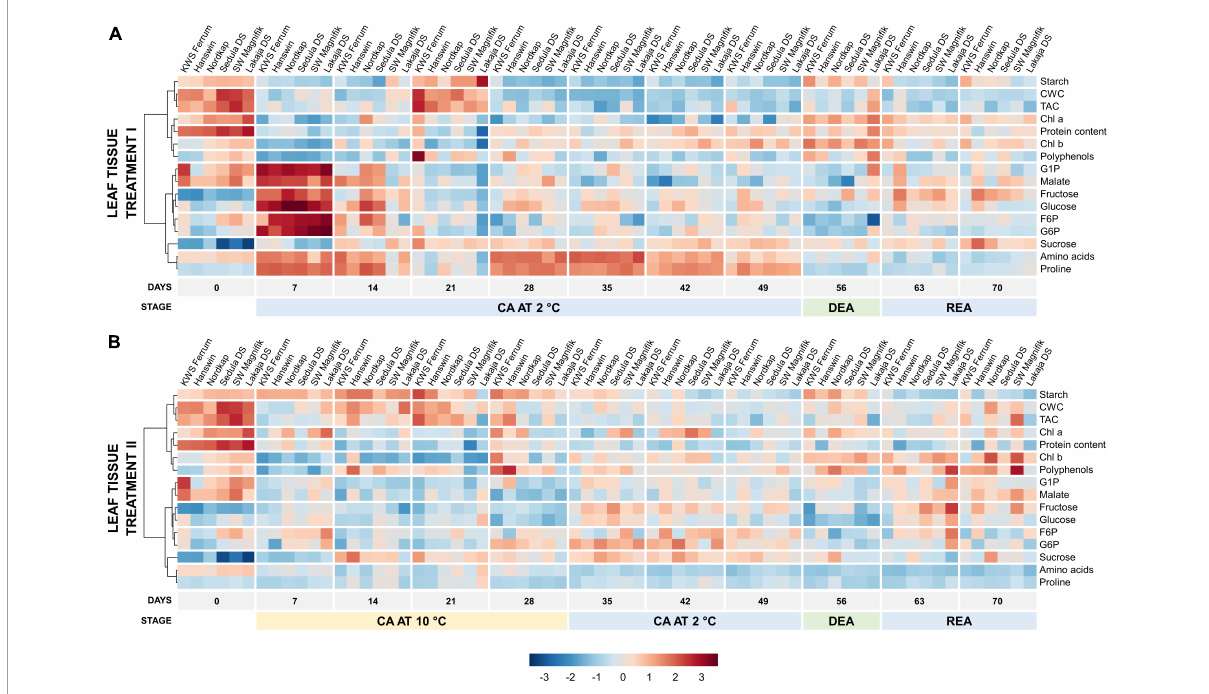
FIGURE4 Evolution of major biomass components and sugar-phosphates in the leaves of 6 winter wheat genotypes during two CA, DEA, and REA treatments. Heatmaps of metabolite concentrations in treatment I (A) and treatment II (B) . Each column represents the results of a single genotype on a given time-point. The genotypes are ordered by FT, from lowest to highest (“KWS Ferrum,” “Hanswin,” “Nordkap,” “Sedula DS,” “SW Magnifik,” “Lakaja DS,” respectively). Each row represents the scaled concentration of a given metabolite; a single cell signifies the average value of three biological replicates. Low values are marked as blue, and high values are marked as red. The data of both treatments I and II were treated and analyzed simultaneously and are